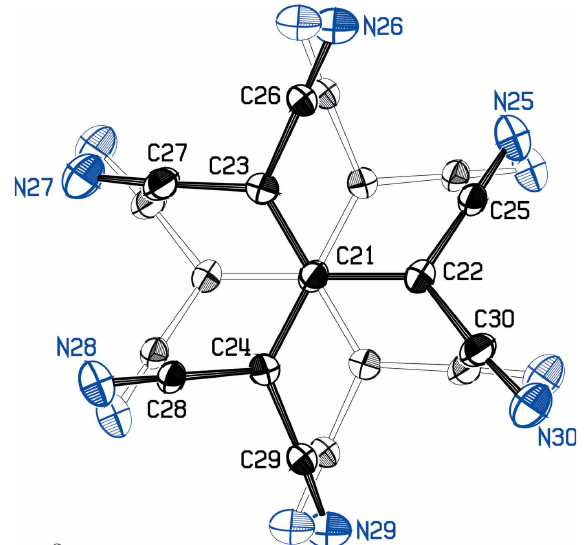
Figure 3 The tcpd 2 (cid:2) anion structure superimposed on its disorder mate related by (cid:2) x , 1 (cid:2) y , 1 (cid:2) z ). Atom C21 lies on the center of symmetry at ( 3 ( 3 2 2